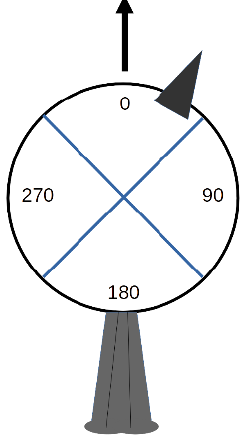
Figure 1. Head orientation of Florida scrub-jay sentinels was determined using the position of the bill (small dark triangle) in one of four possible quadrants from an imaginary circle around the head of the bird. Mid-point angles are shown along with the position of the tail at the bottom. Direction of the long axis of the body is shown with an arrow. Quadrants 1 to 4 correspond to the following mid-point angles: 0, 90, 180, and 270, respectively.